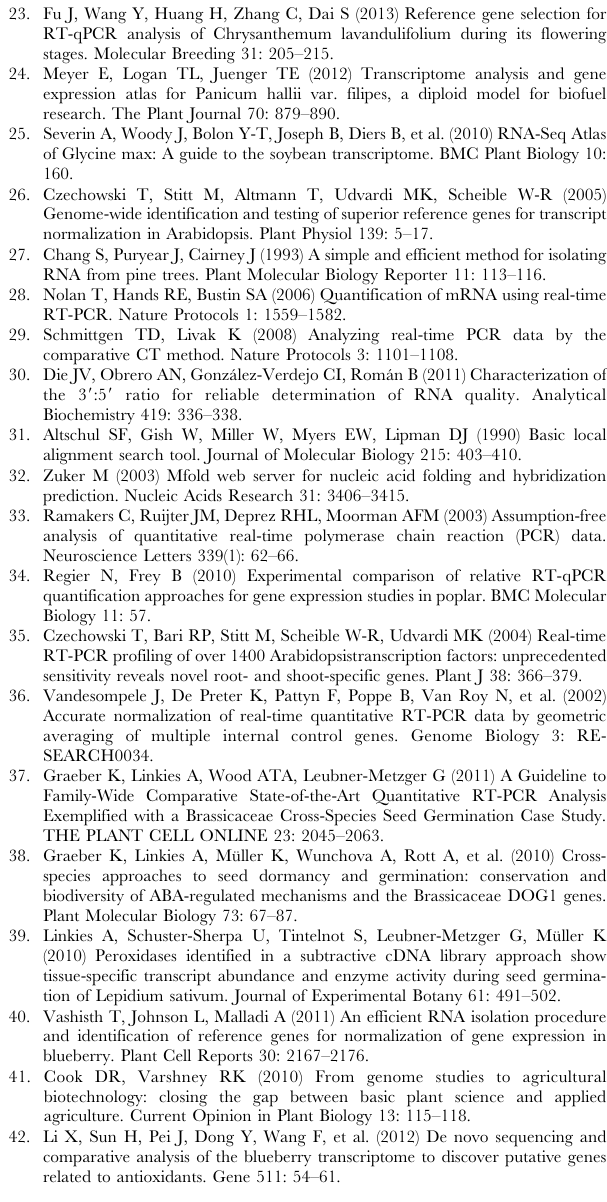
Table S1 Description of reference genes, Arabidopsis Gene Index (AGI) orthologous identifiers and blueberry